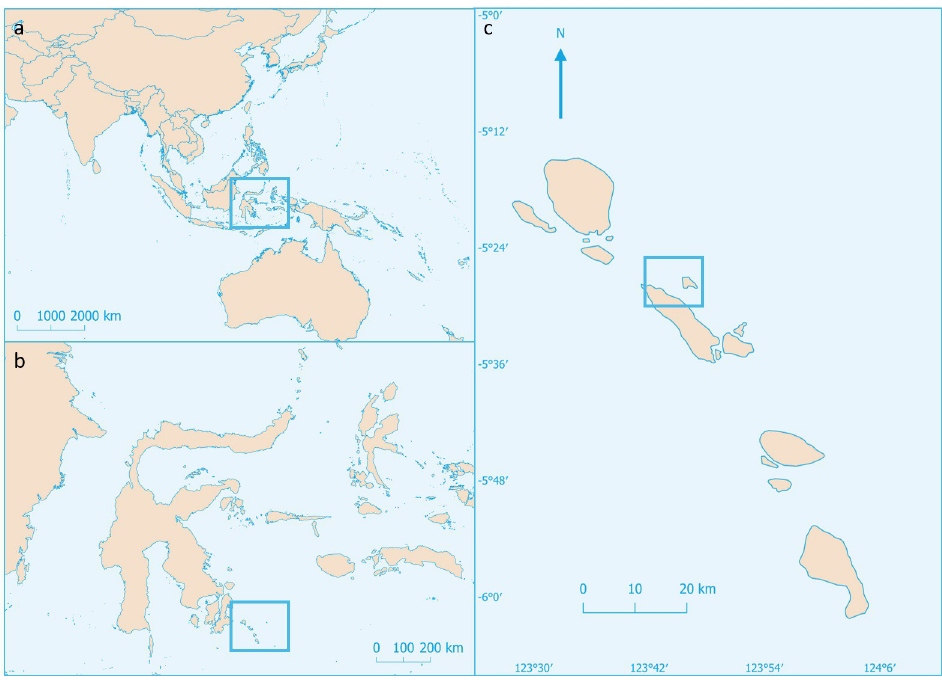
Fig 1. Sampling location. Boxed areas represent: a) Sulawesi, b) Wakatobi National Park, c) monitoring area.